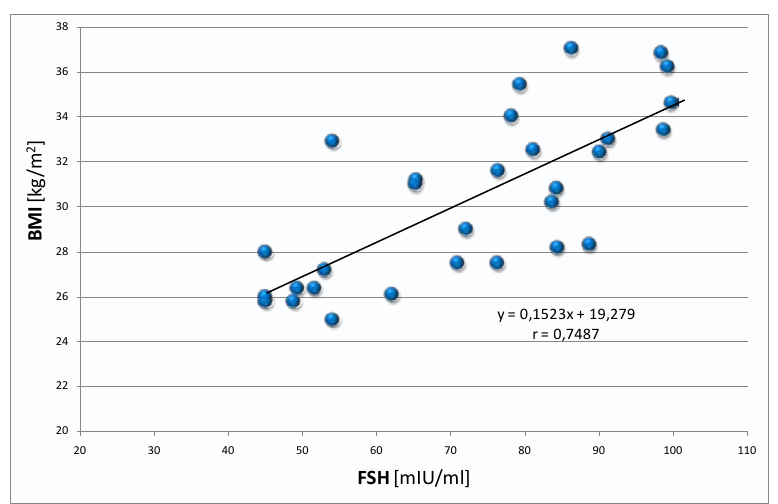
Figure 6. Correlation between the level of FSH and BMI in the group of overweight women (group